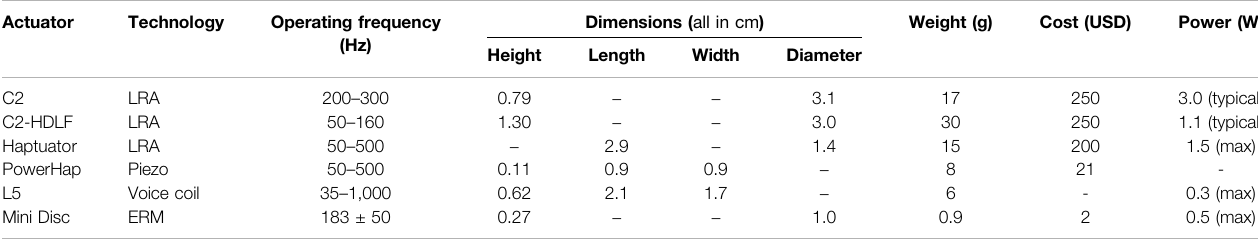
TABLE 1 | Comparison of commercially available